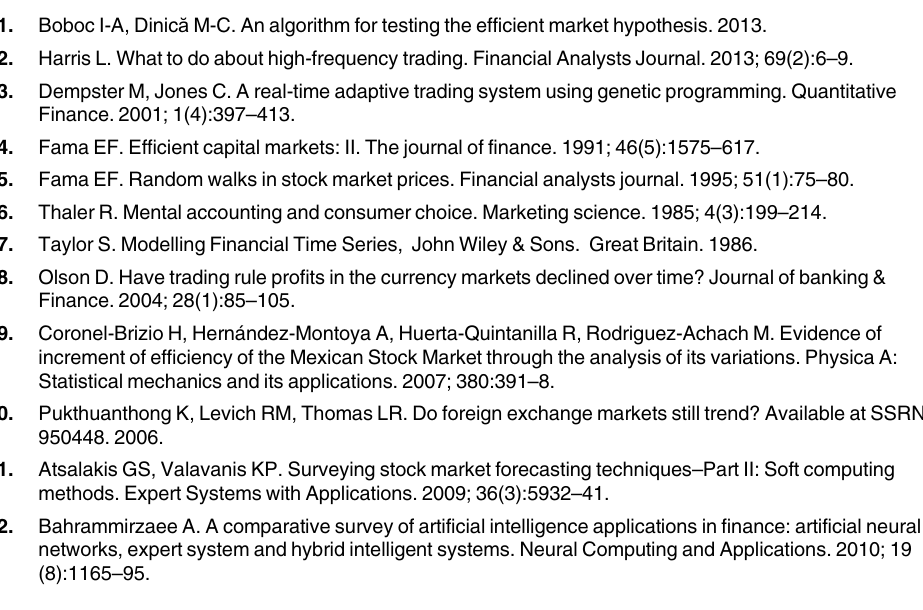
S1 Table. Results for unit root test. S2 Table. Results for Johansen cointegration test. S3 Table. Results for error correction model. S4 Table. Results for serial correlation